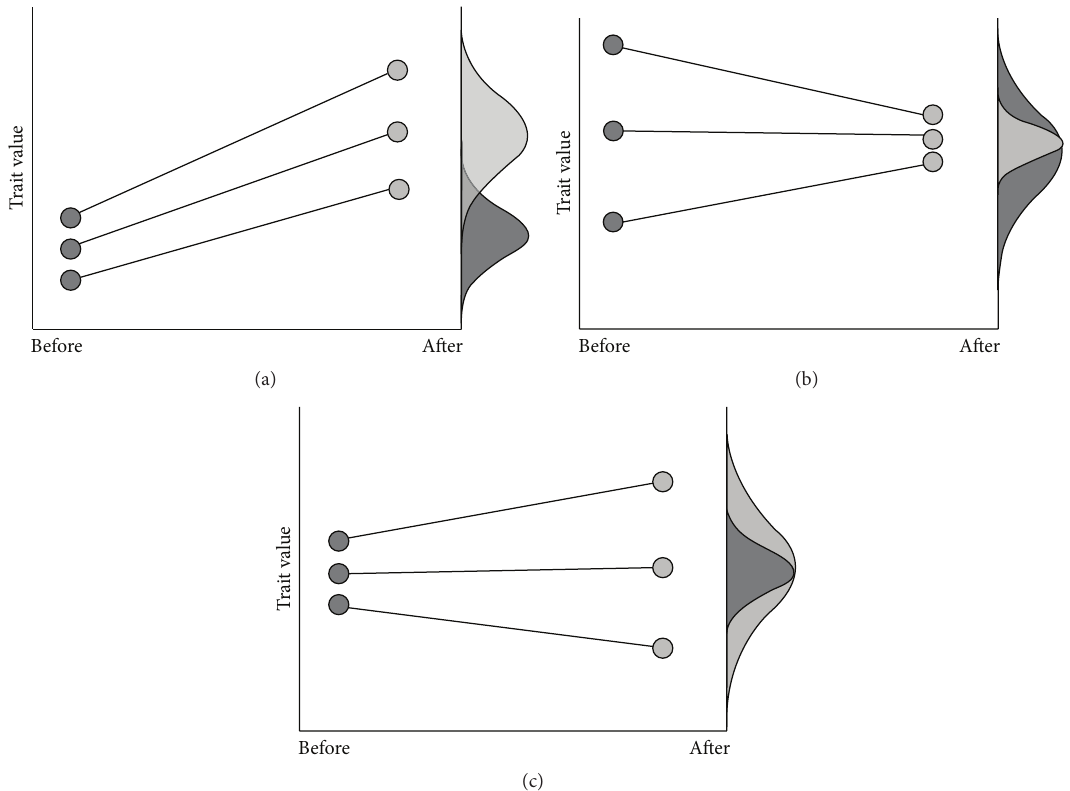
Figure 2: Scenarios for change in the mean and/or variance of a trait in a population between constitutive phenotypes expressed prior to an interaction (dark shading) and the induced phenotype following an interaction (light shading). (a) An increase in mean and variance of a trait. (b) A decrease in variance, mean unchanged. (c) An increase in variance, mean unchanged from